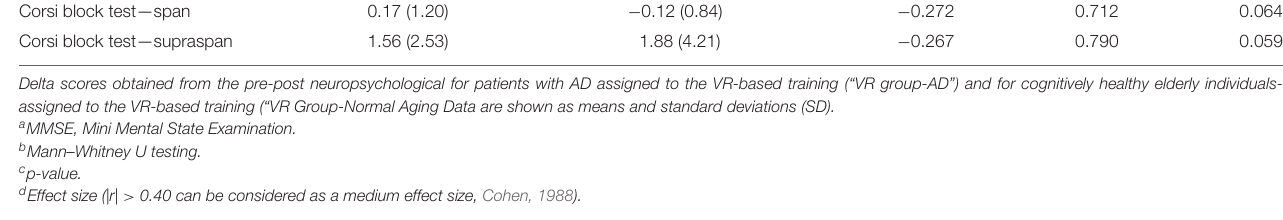
Verbal categorical